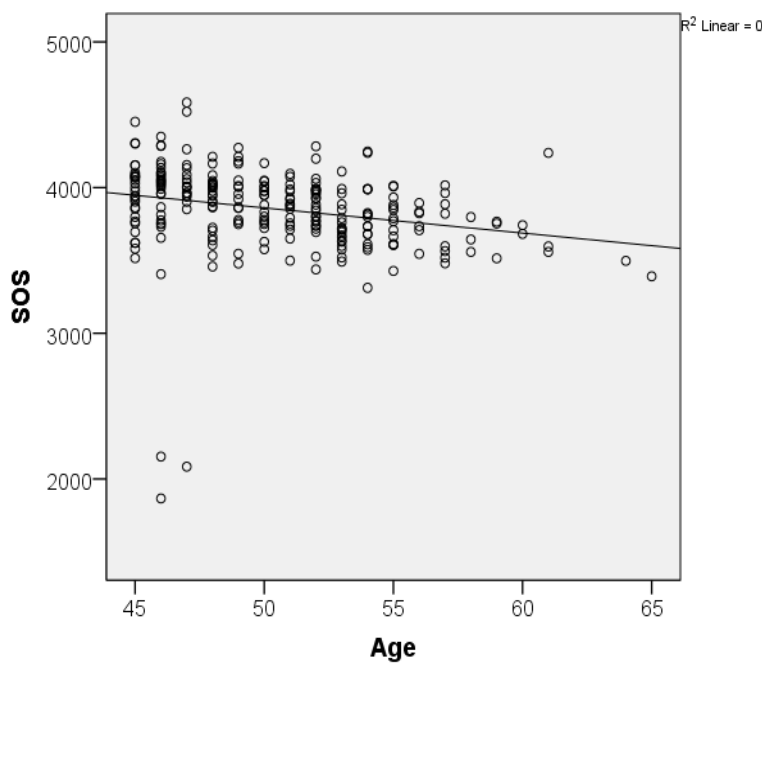
Figure 1. Correlation between age and bone mineral